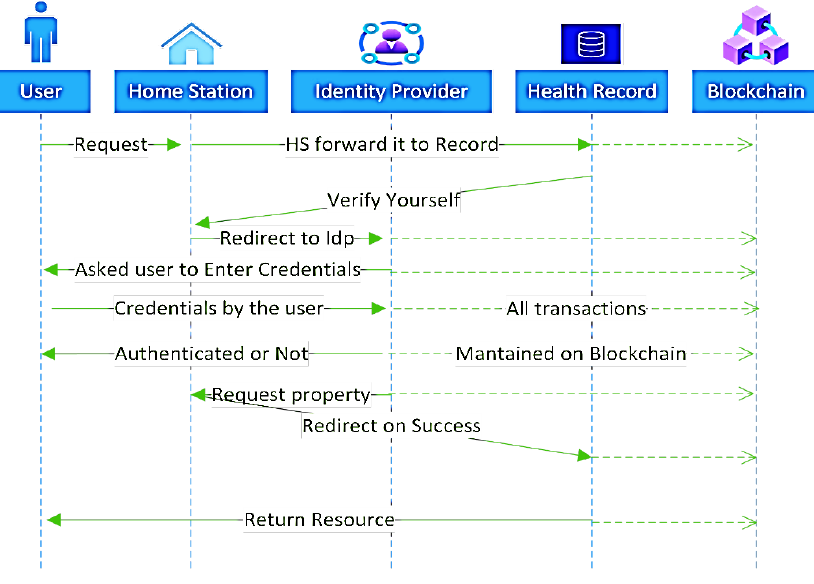
Figure 6. Proposed s ystem’s sequence diagram.